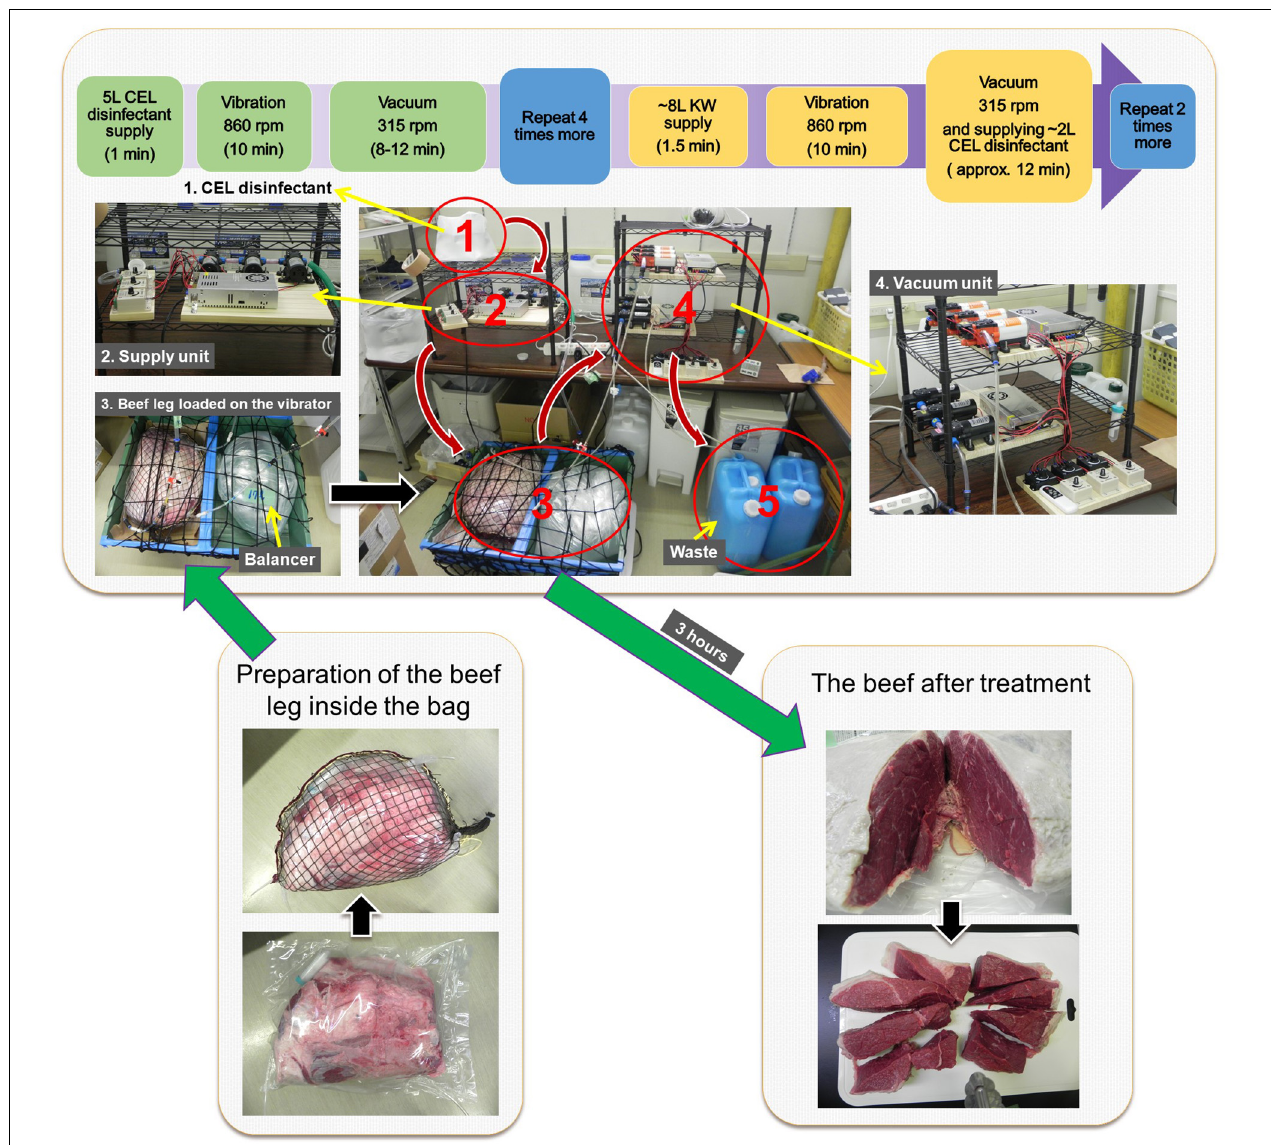
FIGURE 6 | A summarized protocol of the vibration-vacuum disinfection (VV)